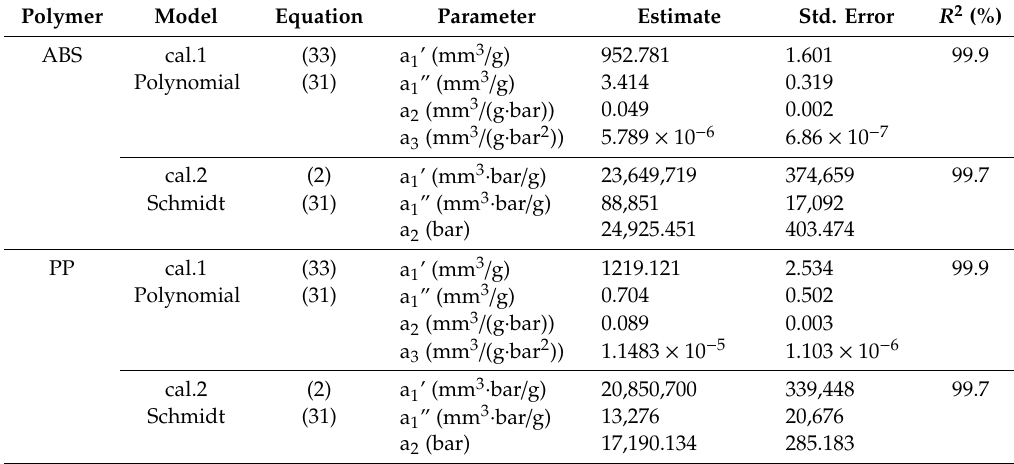
Figure 6. The corresponding specific volume at the transition temperature of the amorphous ABS ( a ) and the semi-crystalline PP ( b ) as a function of the cooling rate. Table 2. Parameters for the correspondent specific volume at the transition temperature, vt, estimated by the continuous two-domain EoS considering the cooling rate.